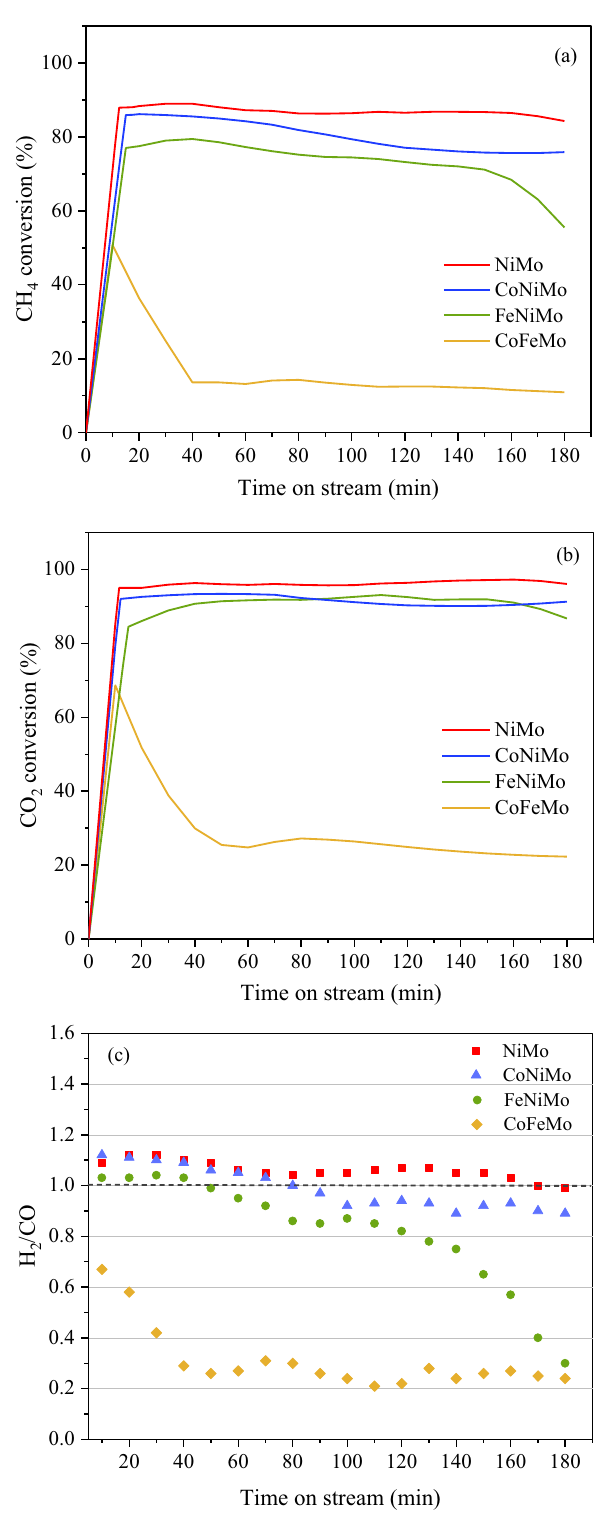
Figure 4. (a) CH 4 conversion, (b) CO 2 conversion, and (c) H 2 /CO ratio as a function of time on stream at 800 °C for 3 h, GHSV = 48,000 ml/gCat-h, over a bimetallic catalyst (NiMo) and trimetallic catalysts (CoNiMo, FeNiMo, and CoFeMo) supported on